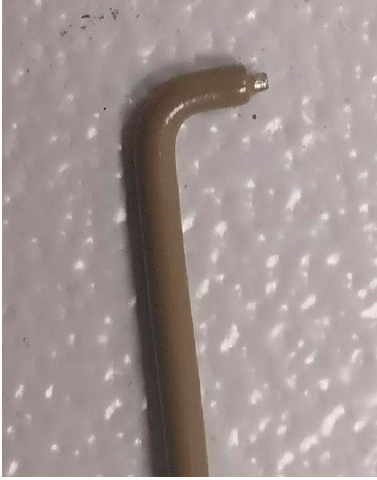
Figure 2. Wide tip used in the procedure.